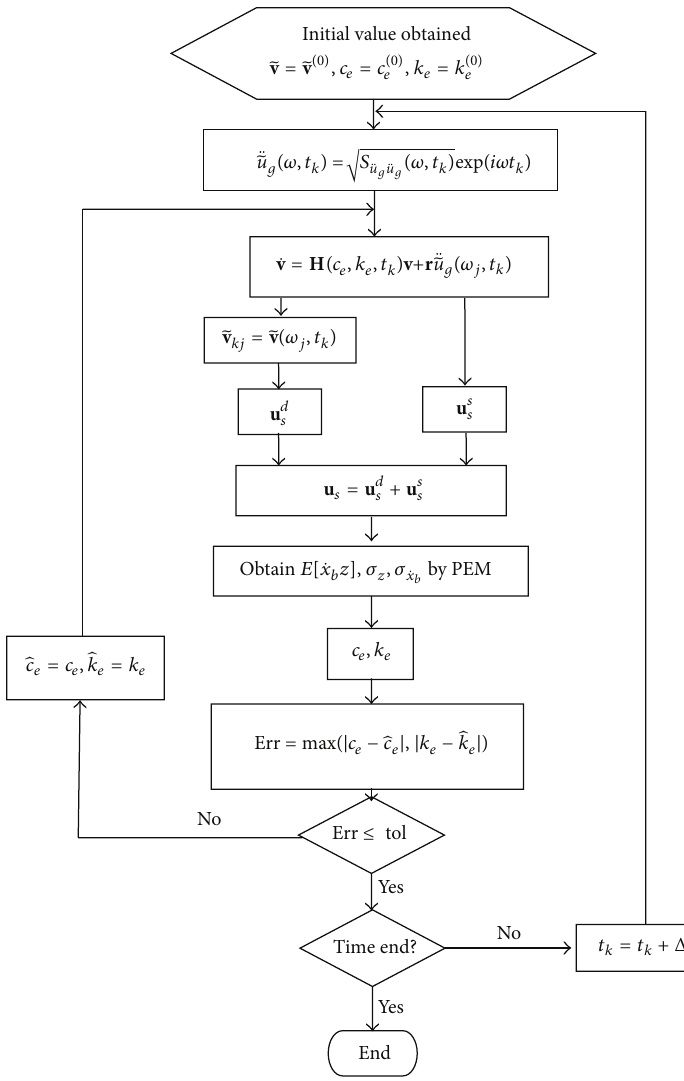
Figure 1: Flow chart of the computation